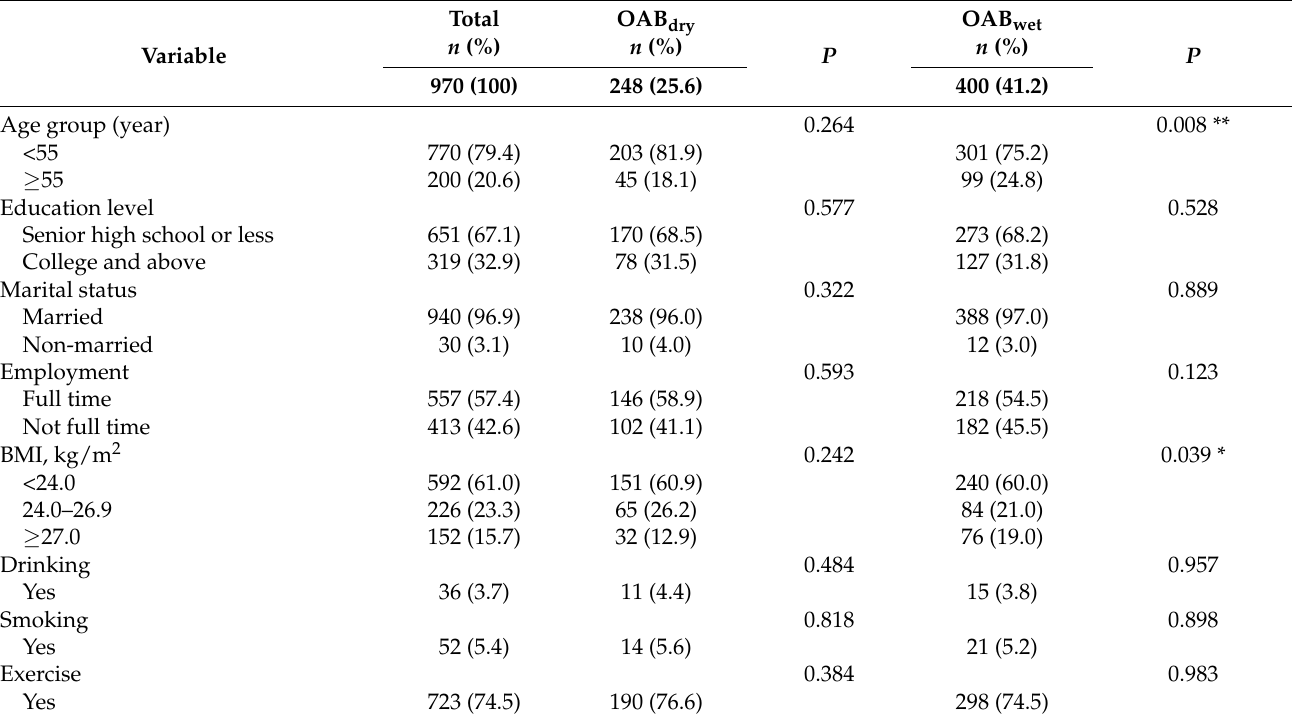
Table 1. Participant characteristics and their associations with OAB dry and OAB wet